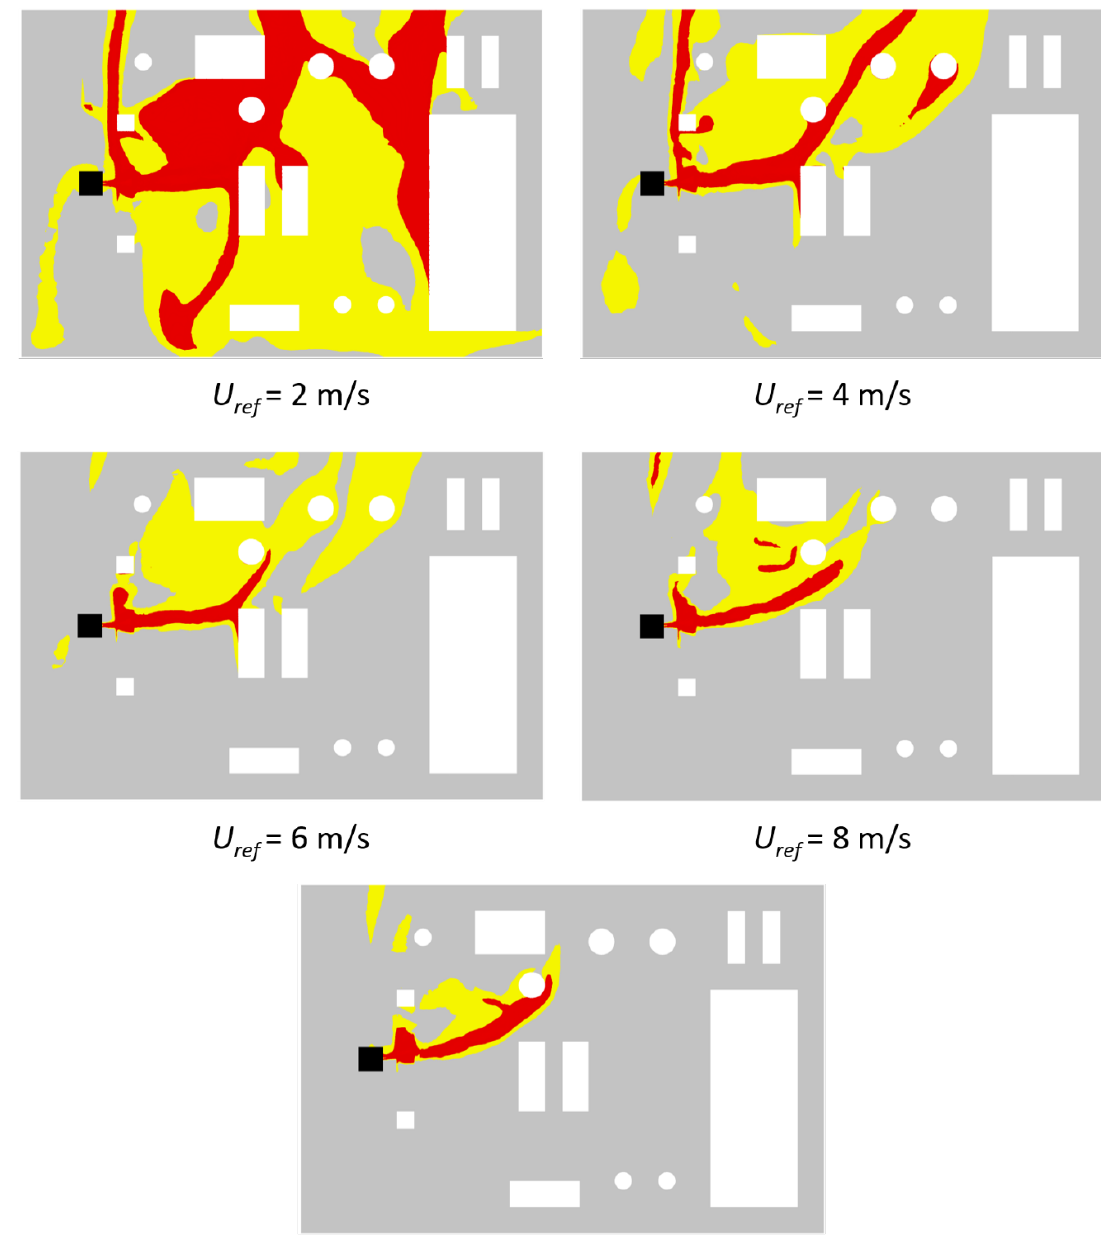
Figure 11. Contour plots on a platform section at height 1.5 m: area with mixture concentration above 0.5 LFL in yellow and flammable areas in red.